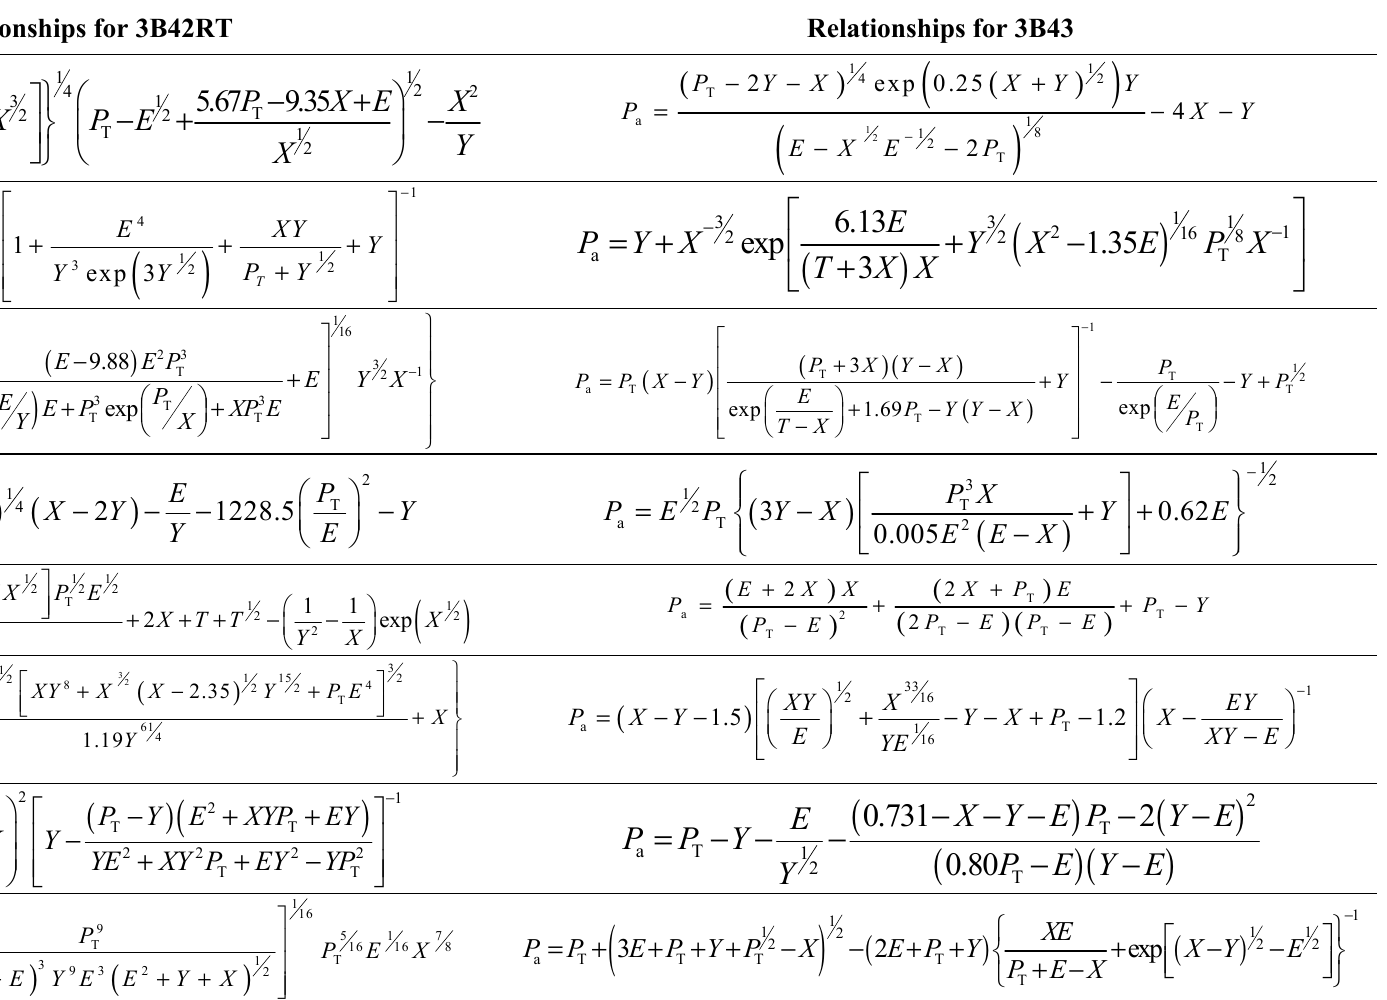
Table A1. Relationship between actual rainfall and related factors ( P T : TMPA rainfall; E : elevation; X : longitude; Y : latitude).